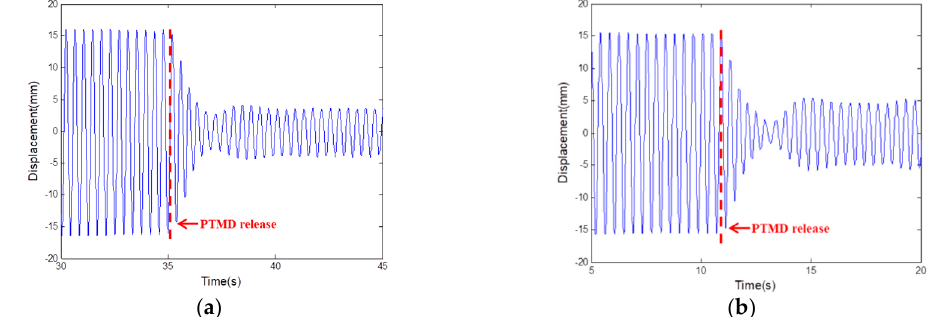
Figure 9. Experimental results of forced vibration when the mass of the SMA–PTMD is released mid-vibration: ( a ) Spring steel type; ( b ) pendulum type.